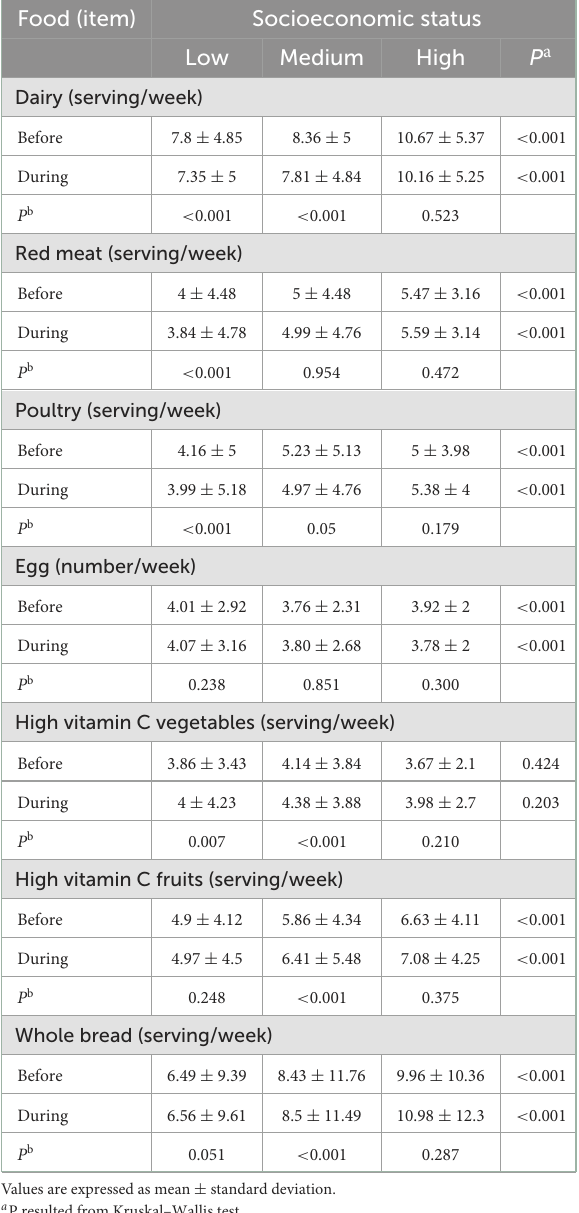
TABLE 5 Food intake in each socioeconomic status before and during COVID-19 pandemic. Food